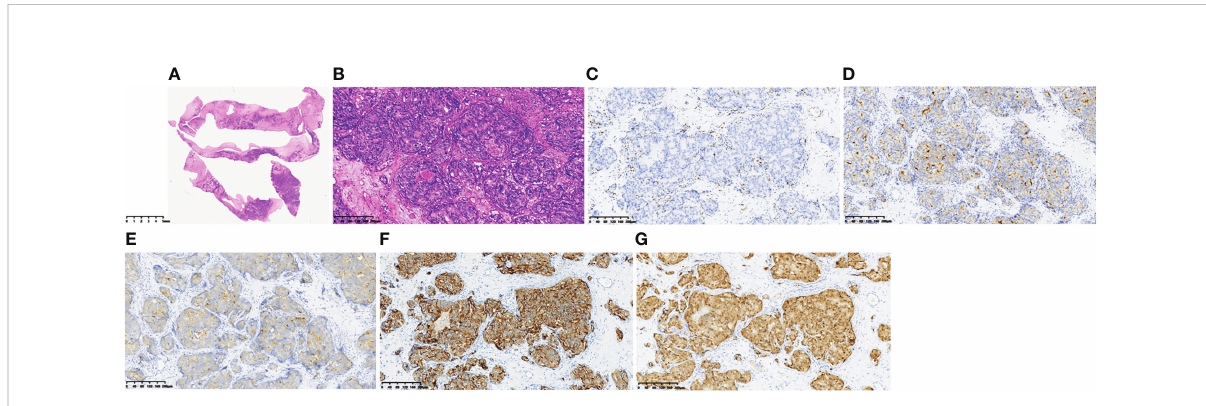
FIGURE 2 Pathological fi ndings of the haematoma capsule. HE staining (A, B) , ERG immunostaining (C), PSA (+) (D) , PAP (+) (E) , P504S (+) (F) , AR (+) (G)